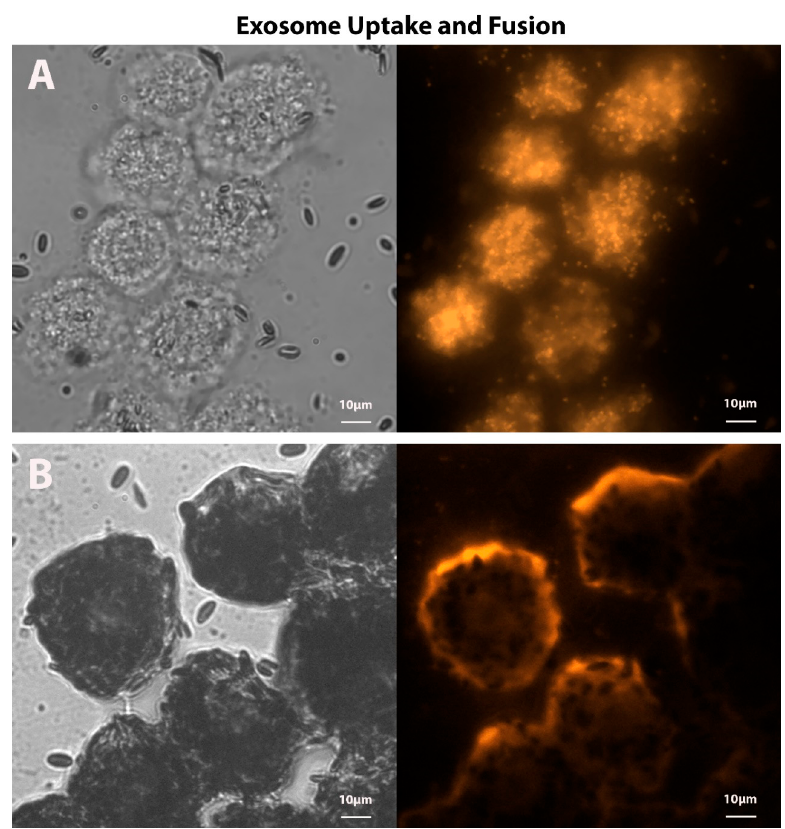
Figure 2. Representative images of possible mechanisms of intercellular communication by exosomes; exosome uptake mediated by endocytosis ( A ) or exosome fusion at the target cell’s plasma membrane ( B ). Paired phase-contrast and fluorescence micrographs of bovine ex-vivo RPE challenged with apical in situ bovine RPE exosomes. Exosomes were labeled with CF555 membrane protein dye to illustrate internalized exosomes taken up by the target unpigmented RPE cells from the tapetum lucidum region of the bovine eye ( A ) or lipophilic octadecyl rhodamine B, R18, membrane dye to illustrate sites of exosome fusion along the plasma membrane of pigmented RPE cells neighboring the tapetum lucidum ( B ). Total magnification = 630 ×